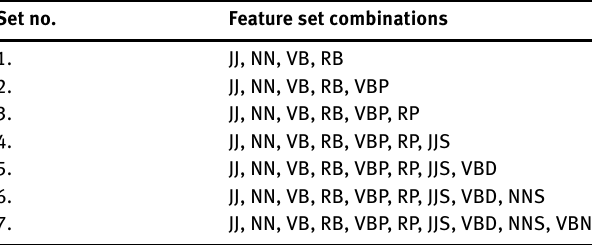
Table 5: Subcategory Combinations.